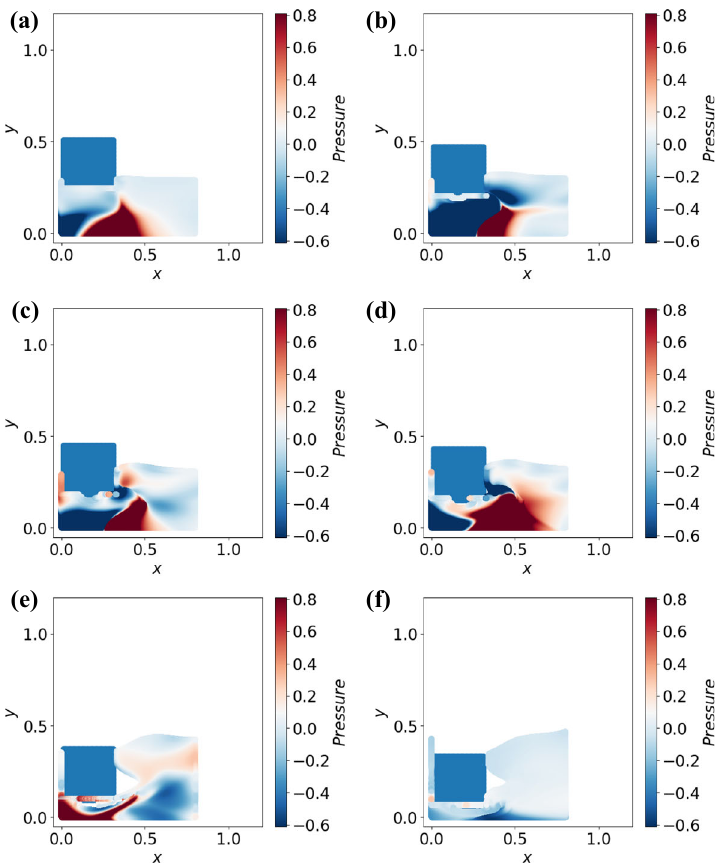
Fig. 8 The surge morphology and pressure distribution diagram. Water depth D = 0 . 288 m and particle density n = 200 / m. Each map corresponds to a different moment. a 3 dt. b 5 dt. c 6 dt. d 7 dt. e 10 dt. f 12 dt